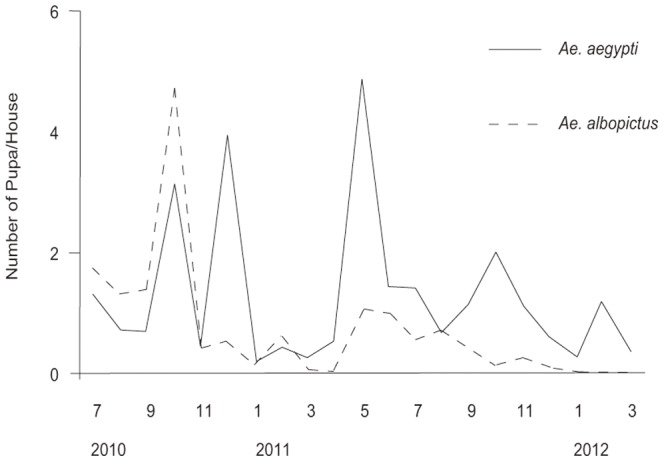
Seasonal occurrence of Ae. aegypti and Ae. albopictus in Hanoi from July 2010 to March 2012.Error bars indicate standard error.